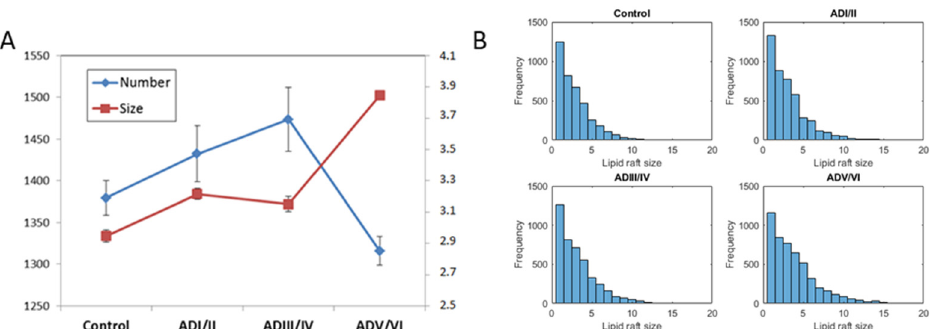
Figure 4. ( A ). Estimation of the number (continuous blue line) and size (dashed red line) of lipid rafts in the four pathological conditions simulated by the model corresponding with the solutions shown Figure 2C. Each point corresponds to the mean ± SD of 10 simulations. ( B ). Frequency histograms of simulated lipid raft sizes.